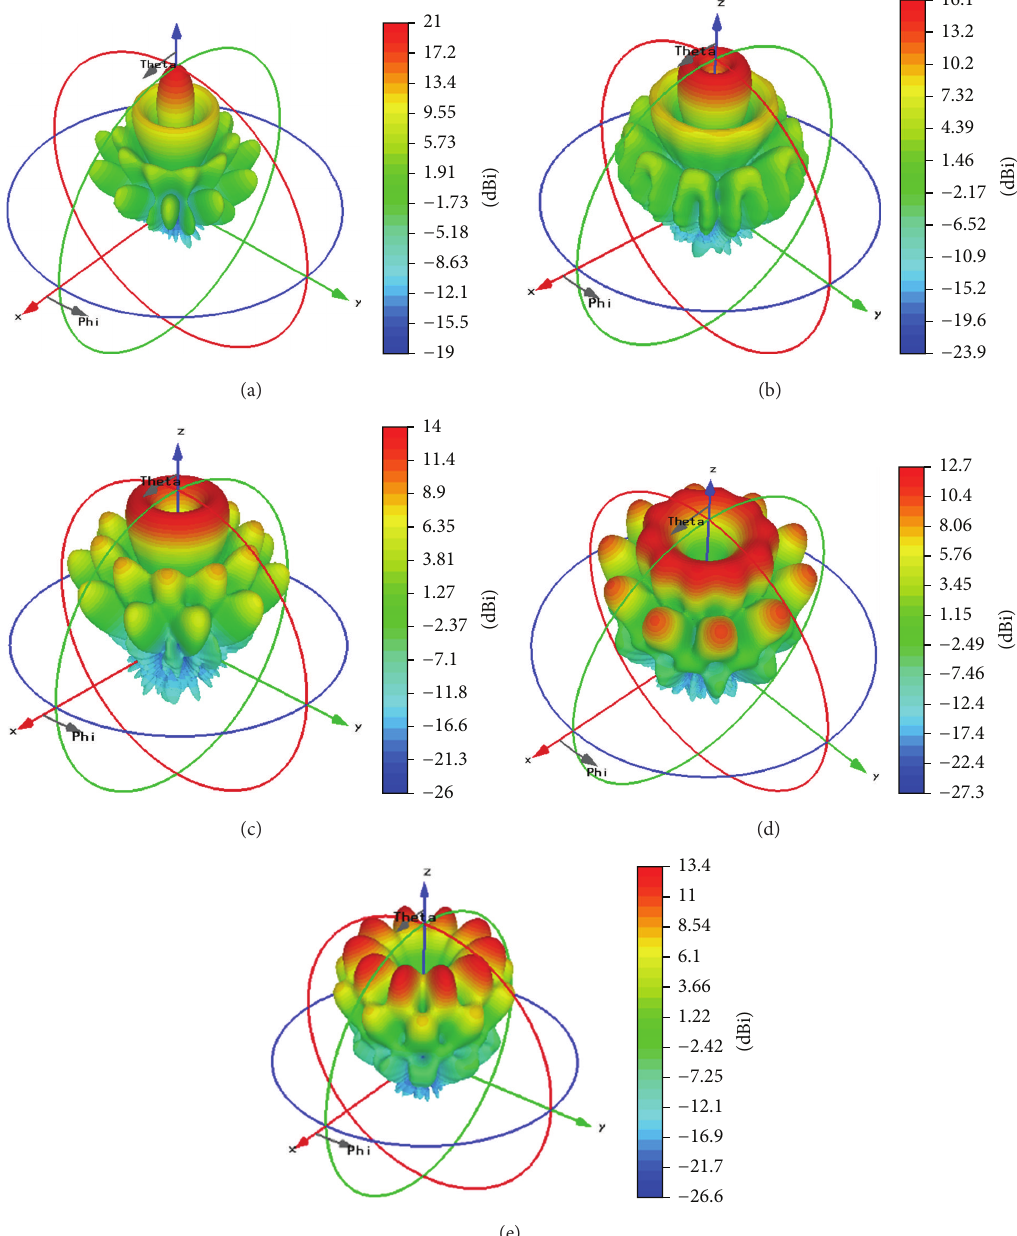
Figure 6: Radiation patterns with different OAM states at 2.2 GHz: (a) ℓ = 0 , (b) ℓ = ±1 , (c) ℓ = ±2 , (d) ℓ = ±3 , and (e) ℓ = ±4